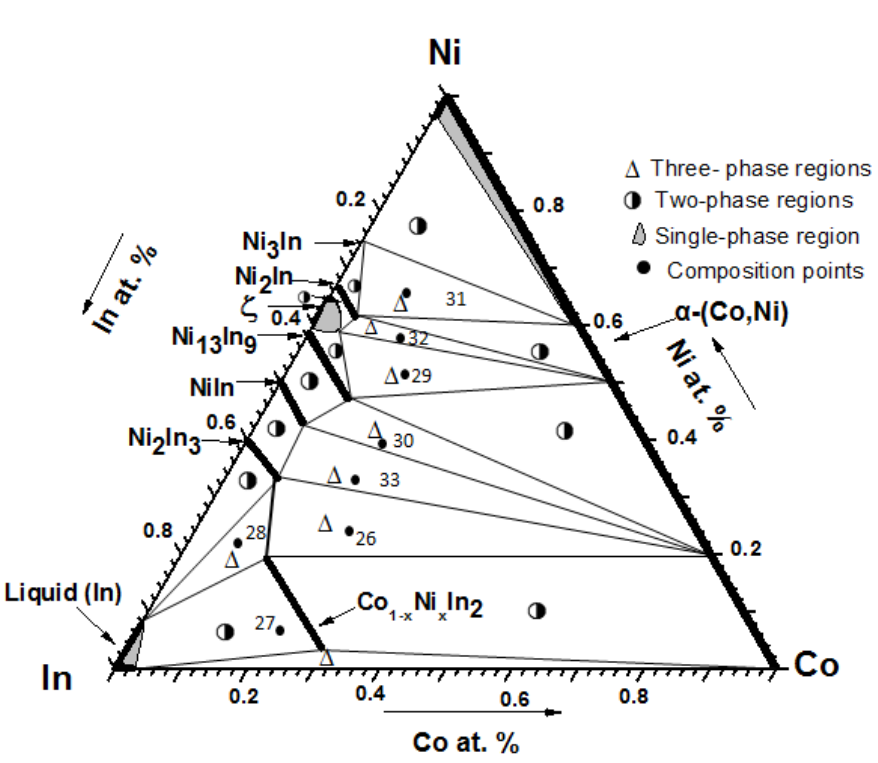
Figure 14. Isothermal section of the Co-Ni-In system at 873 K. Table 3. Typical samples and details of three-phase regions in the Co-Ni-In ternary system at 873 K. Phase Regions Samples Alloy